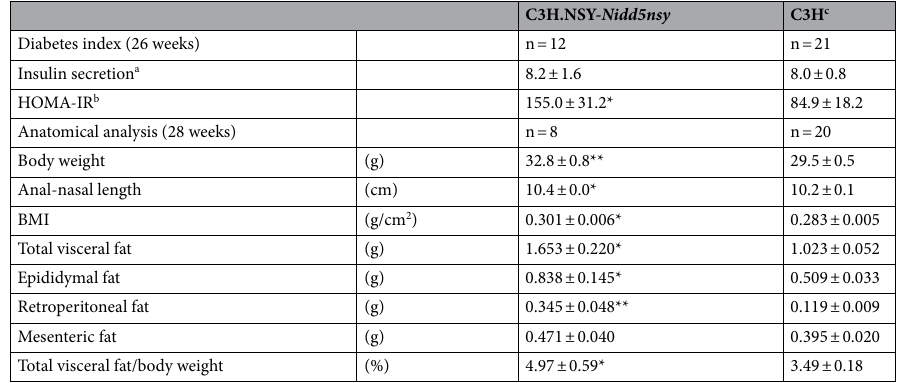
Table 3. Phenotypes in congenic C3H.NSY- Nidd5nsy and C3H mice. Values represent total number or mean ± SEM. Characteristics were compared using the Mann–Whitney U test. * P < 0.05, ** P < 0.01. a Assessed by insulinogenic index (incremental insulin area under the curve (AUC) [pmol/L] divided by incremental glucose AUC [mmol/L]) after glucose challenge. b Calculated from basal insulin and glucose concentrations (fasting glucose [mmol/L] × fasting insulin [pmol/L]). c C3H mice data were previously reported 12